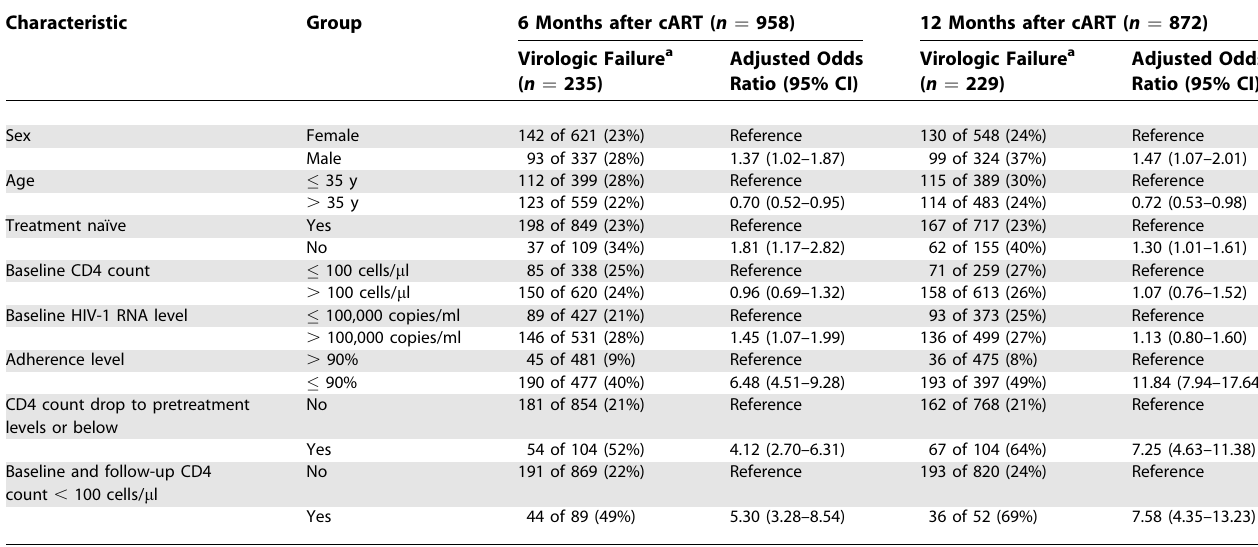
Table 1. Characteristics of Patients with and without Virologic Failure at 6 and 12 Months Characteristic